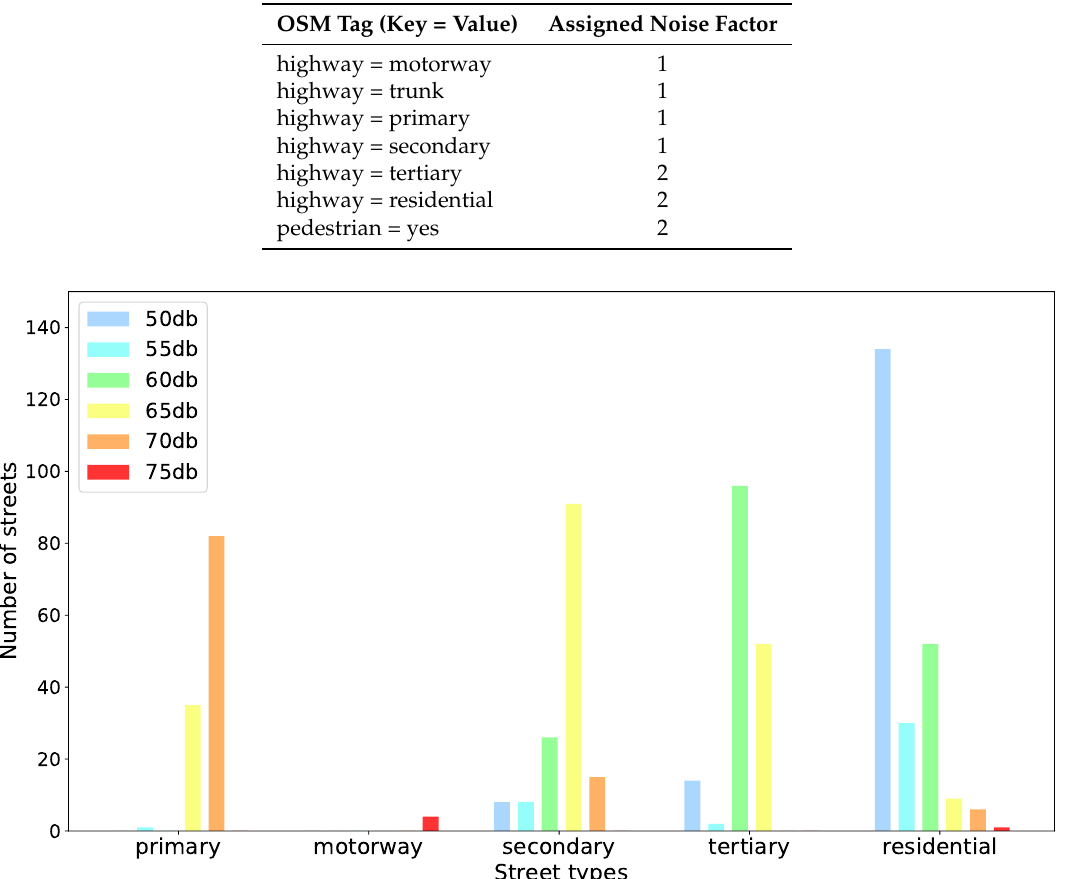
Figure 4. Distribution of noise intensity levels for each OpenStreetMap highway type. The noise intensity data from each street segment was collected and provided by the city of Heidelberg